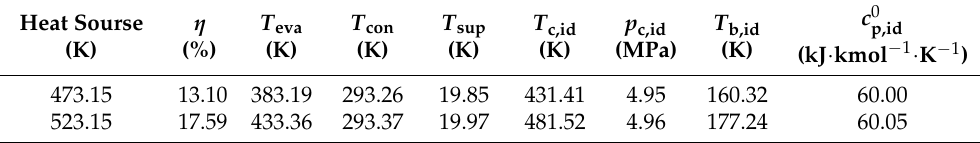
Table 9. Optimization results of simple ORC at typical geothermal source